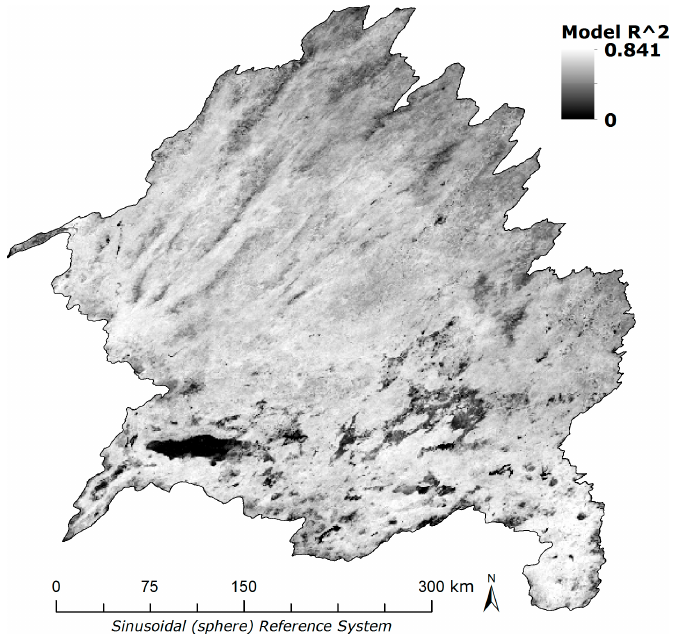
Figure 4. Coefficient of determination (R 2 ) of modeled variability in EVI with temperature, precipitation, and elevation as independent variables in 2001–2007 series across the Lerma-Chapala- Santiago